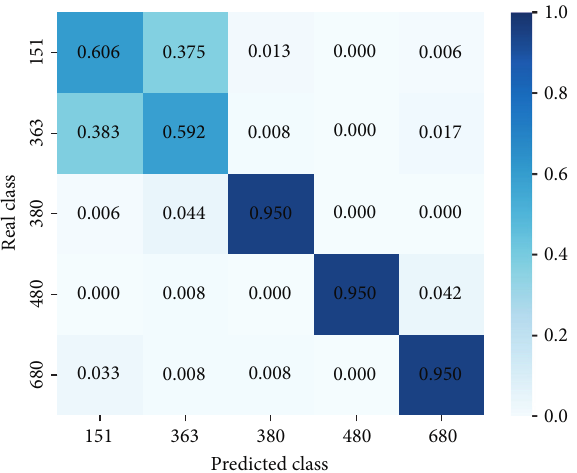
Figure 8: Mean confusion matrix for the best performing CNN for scenario